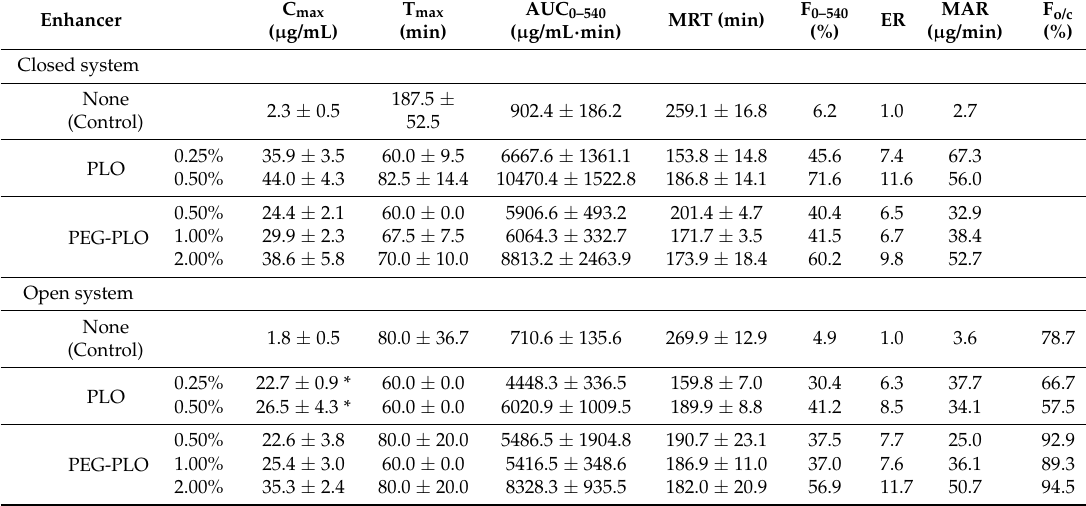
Table 4. Pharmacokinetic parameters of FD-4 after i.n. administration in rats under closed and the open